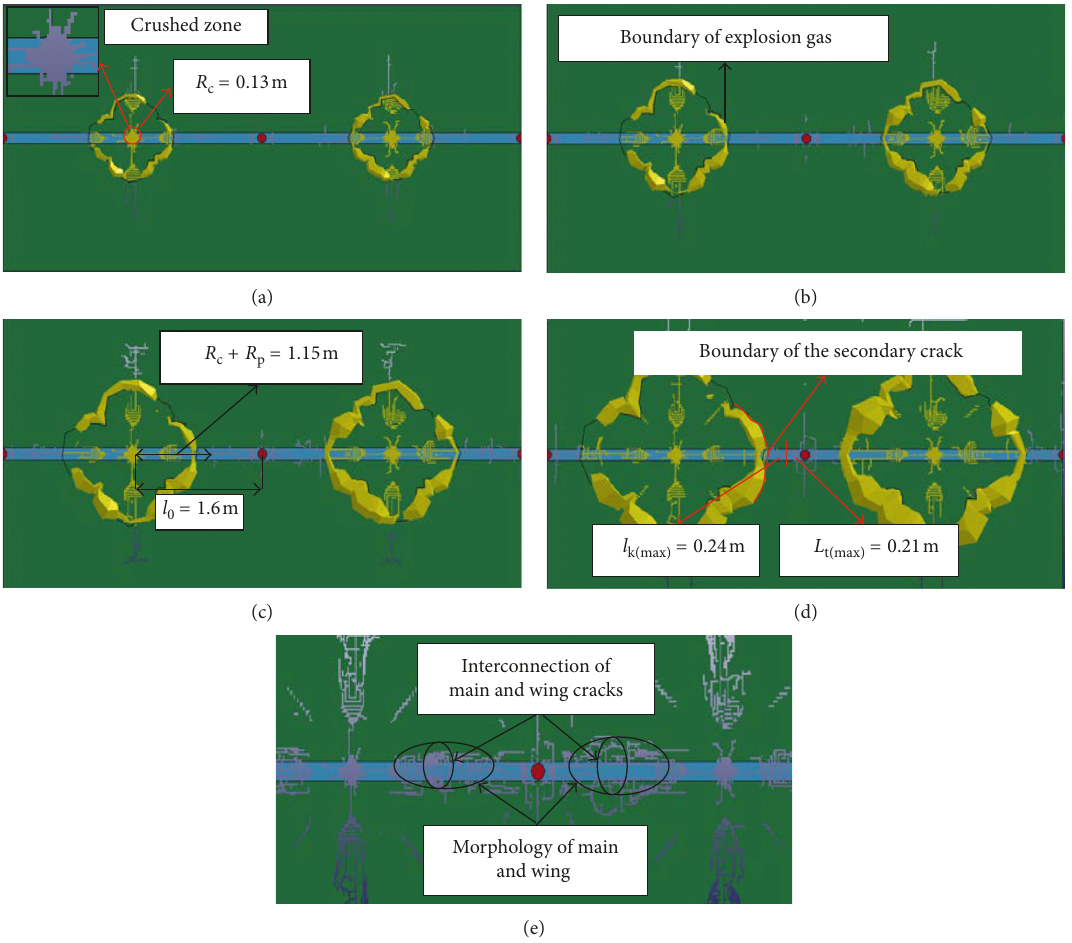
Figure 17: Evolution law of fracture field. (a) 196.2 μ s. (b) 341.5 μ s. (c) 490.1 μ s. (d) 681.3 μ s. (e) 953.7 μ s.